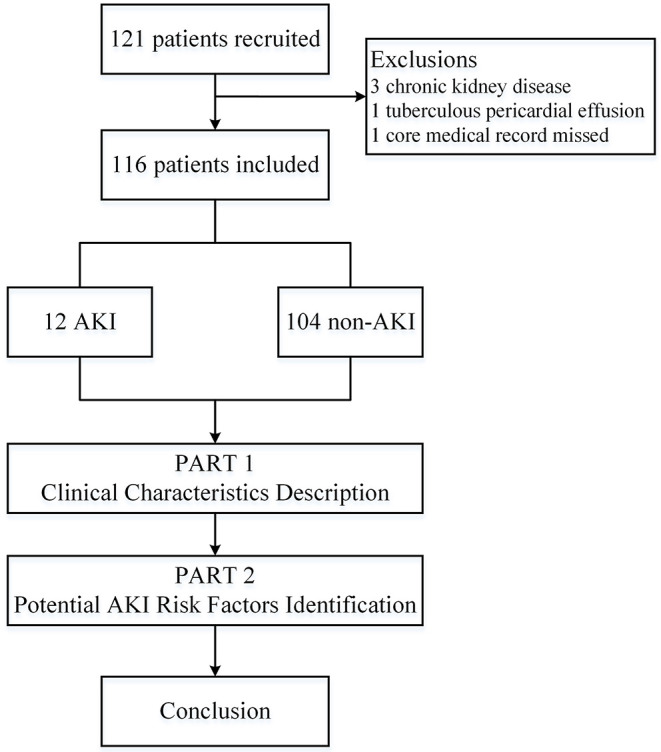
Flowchart of the study. AKI, acute kidney injury.